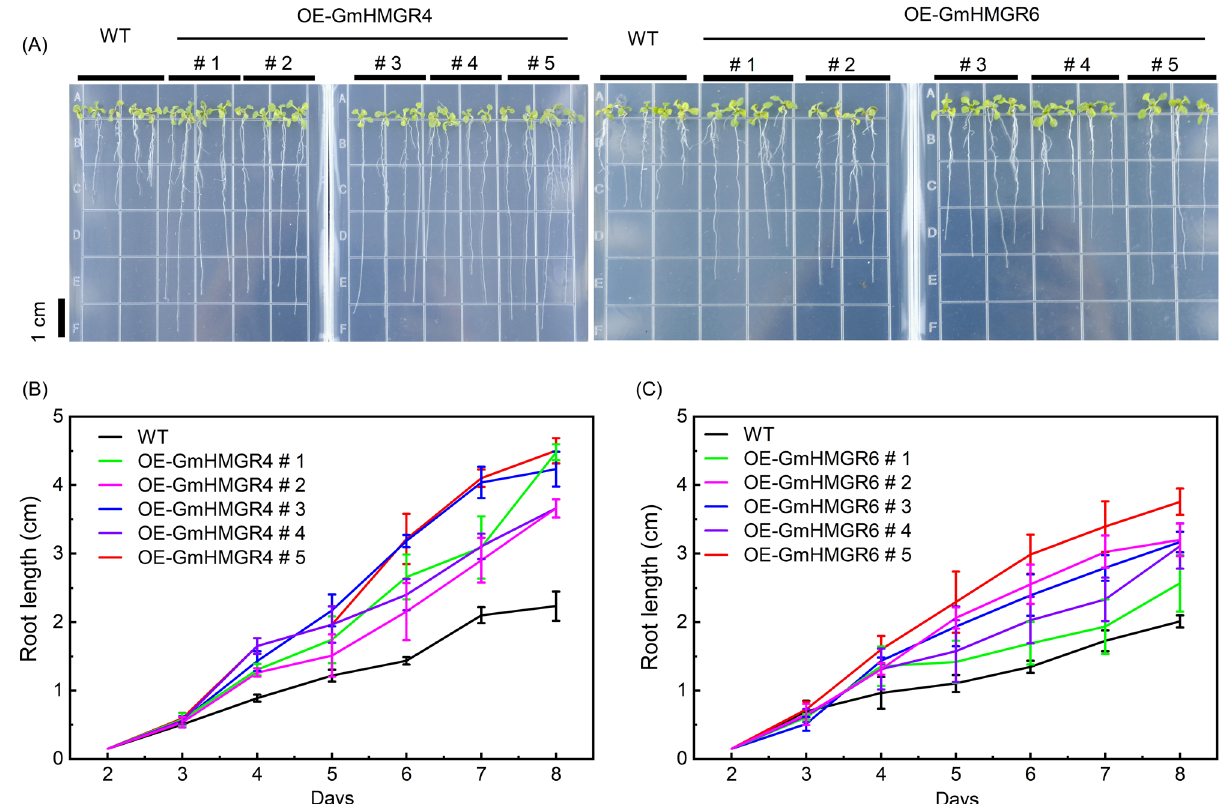
Figure 7. A. thaliana primary root growth during an 8-day period for the WT, OE-GmHMGR4s and OE-GmHMGR6s. ( A ) Growth phenotypes of A. thaliana grown for 8 days in a vertically placed MS medium. ( B ) and ( C ) Changes in root length between WT and transgenic A. thaliana . WT: wild type, n ≥ 15 roots per overexpression